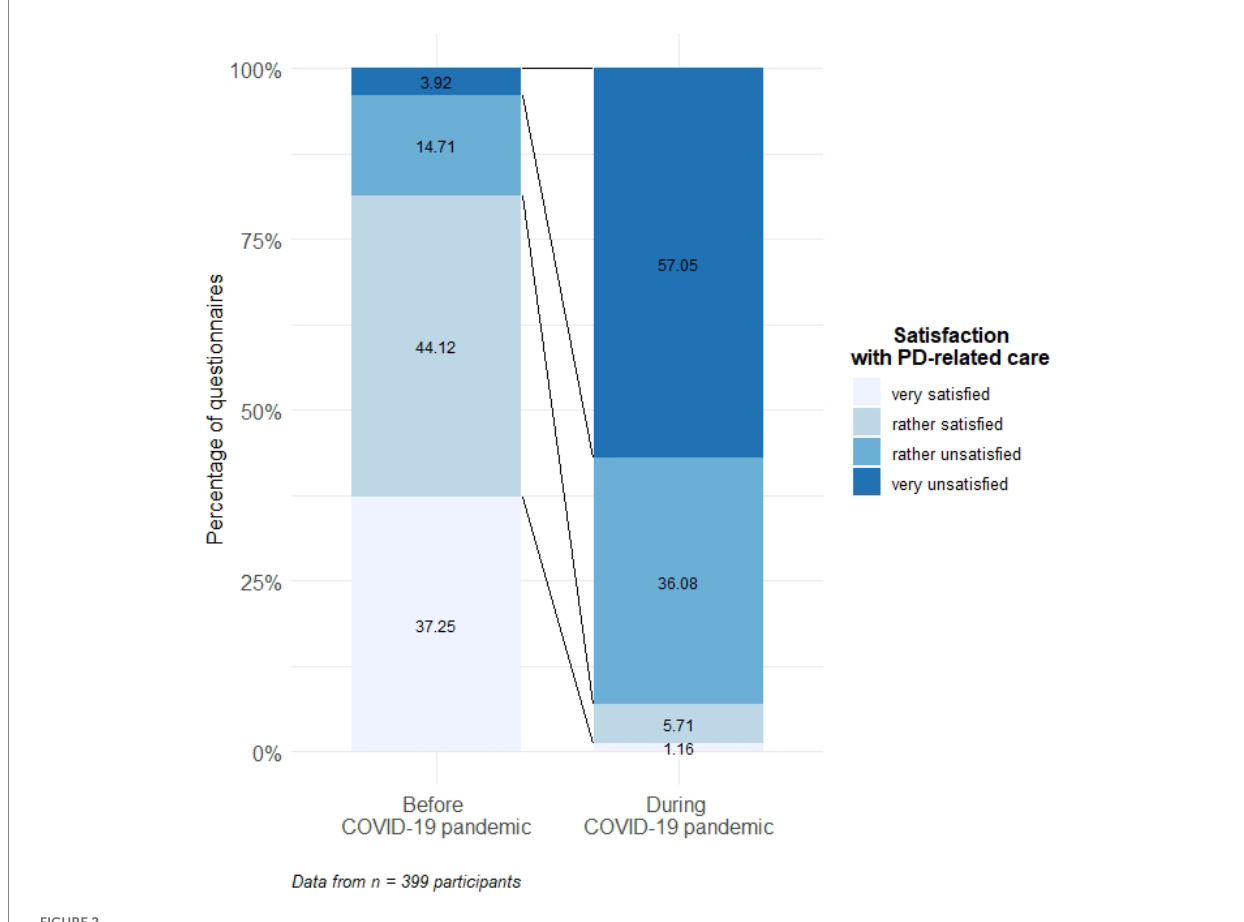
FIGURE 2 B17 vs. C6—Distribution of responses on satisfaction with Parkinsonism-related care before and during the COVID-19